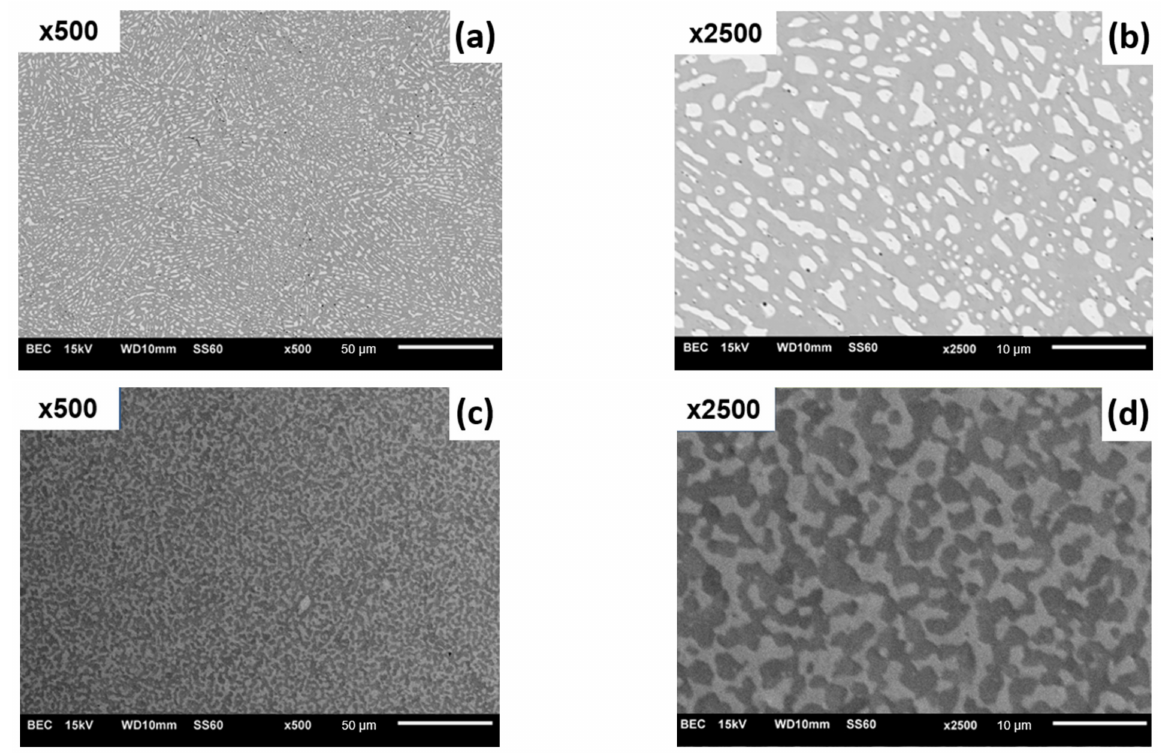
Figure 22. SEM micrographs of NiTa alloy: ( a , b ) L-PBF + VHT (Case 6), and ( c , d ) HP +